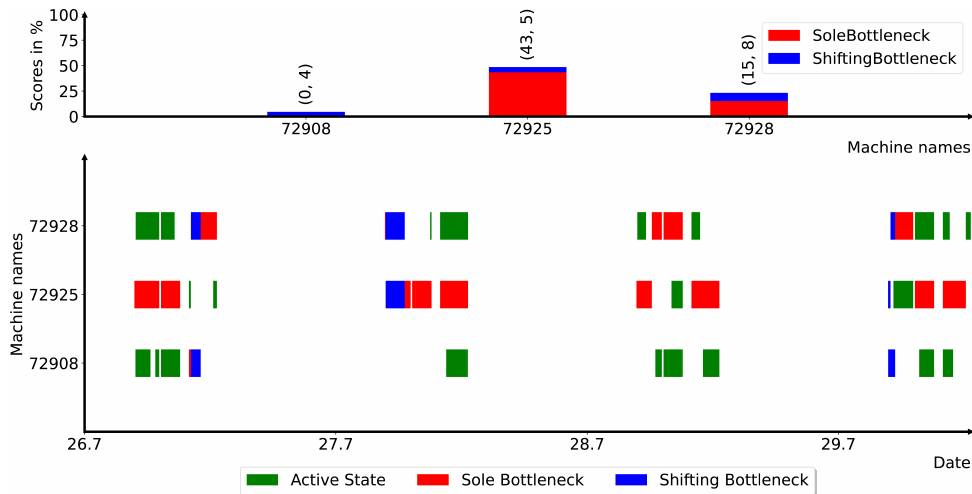
Figure 7. An example for the result of the Active Period Method ( top ) visualized with status time series ( bottom